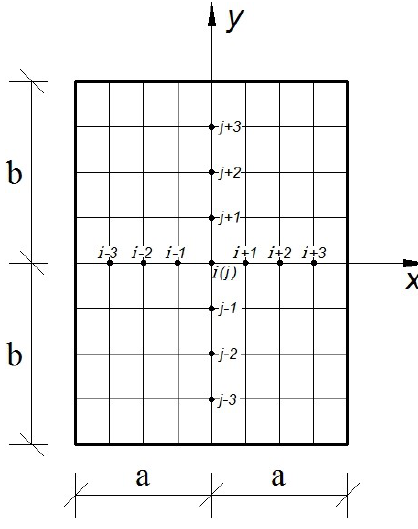
Figure 2: The surface of the shell is divided into a grid with a cell of 8 ×